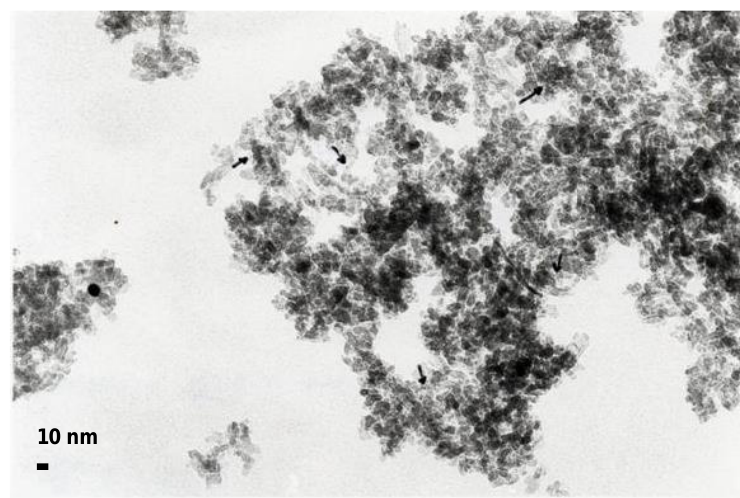
Figure A2. Microphotography of Ru/Al 2 O 3 -Na(1 wt%) catalyst.